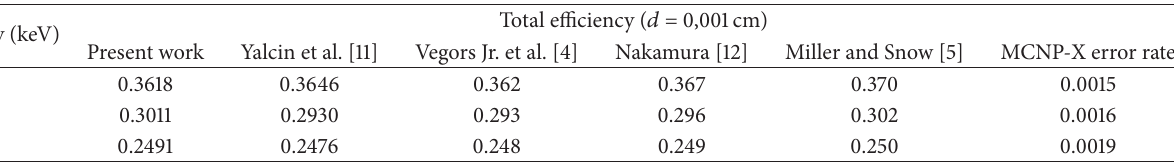
Table 1: Total efficiency values for 3 × 3 inch NaI(Tl) detector with a point source located 𝑑 = 0.001 cm away from the front surface of the detector.